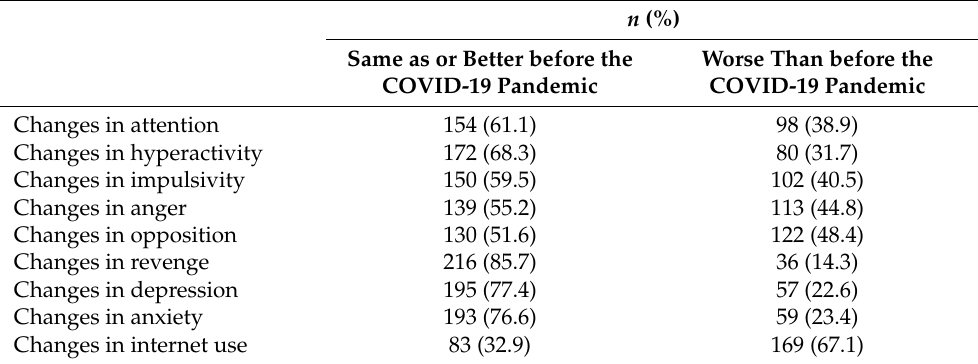
Table 2. Changes in ADHD, ODD, and emotional symptoms and internet use of children with ADHD during the COVID-19 pandemic (N =